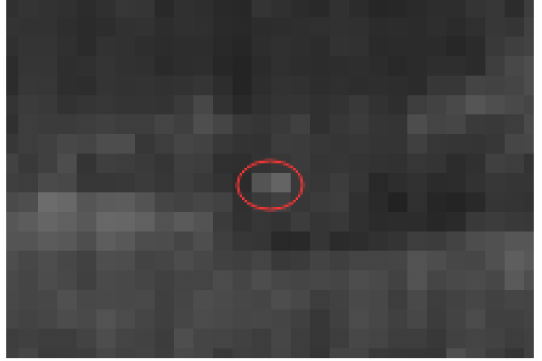
Figure 14. Few pixels target. The second type: target and background building highlight part fusion in Figure 15. When the target flies over backgrounds of varying grayscale intensities, some of the high- lighted backgrounds blend in with the highlighted target.